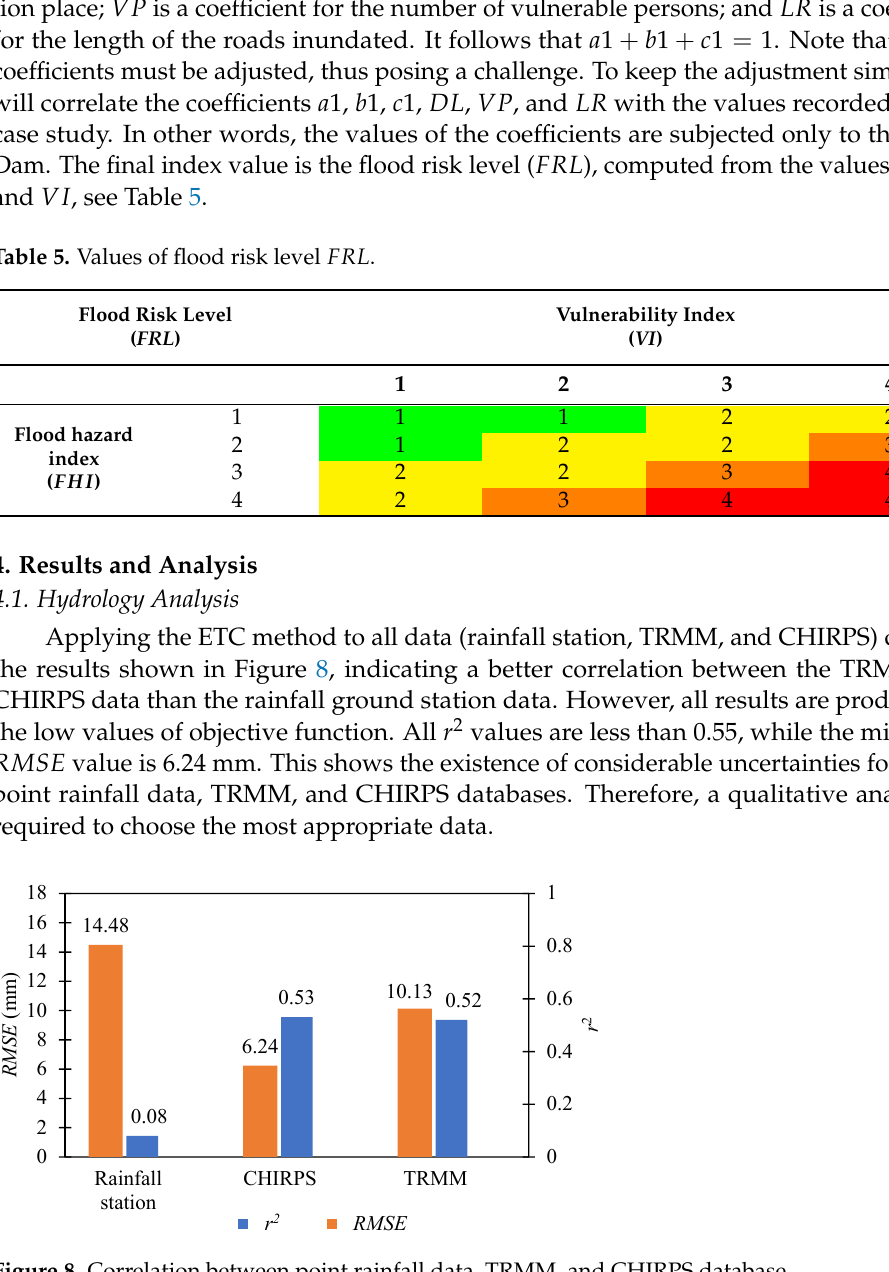
Figure 8. Correlation between point rainfall data, TRMM, and CHIRPS